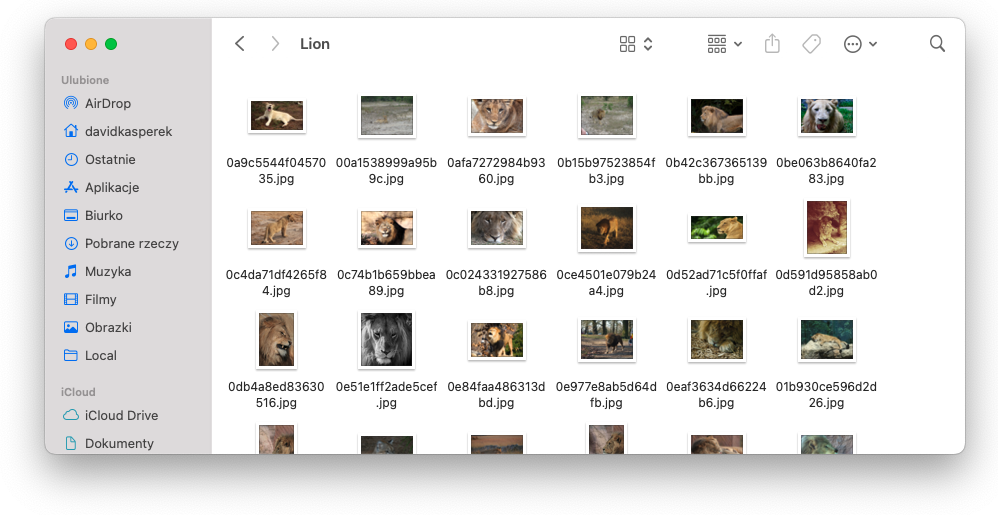
Figure 8. Photos of category ‘Lion’ in the ‘Animals’ training dataset.